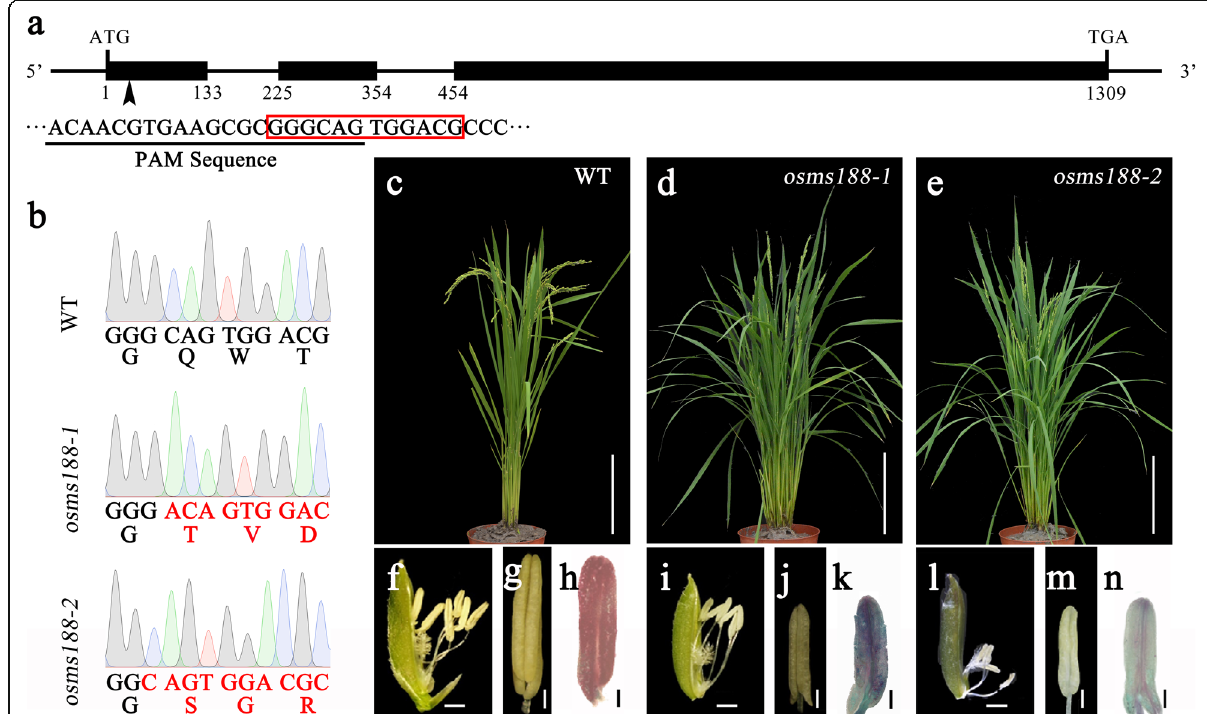
Fig. 1 Mutation of OsMS188 to obtain complete male-sterile mutants. a Gene structure and the editing site of OsMS188 . The black box indicates the exon. The black arrow indicates the site of the PAM sequence. The red box around the sequence shows the mutation sites in b . b Mutation sites of OsMS188 in the wild type (WT), osms188 – 1 and osms188 – 2 ; the red font indicates the variation in nucleic acids and amino acids. c - e Phenotype of WT plant ( c ), osms188 – 1 mutant ( d ) and osms188 – 2 mutant ( e ). f - n Spikelets, mature anthers and Alexander staining of the WT plant ( f - h ), osms188 – 1 mutant ( i - k ) and osms188 – 2 mutant ( l - n ). Bars: ( c - e ) 20 cm; ( f , i , l ) 1 mm; ( g - h , j - k , m - n ) 200 μ